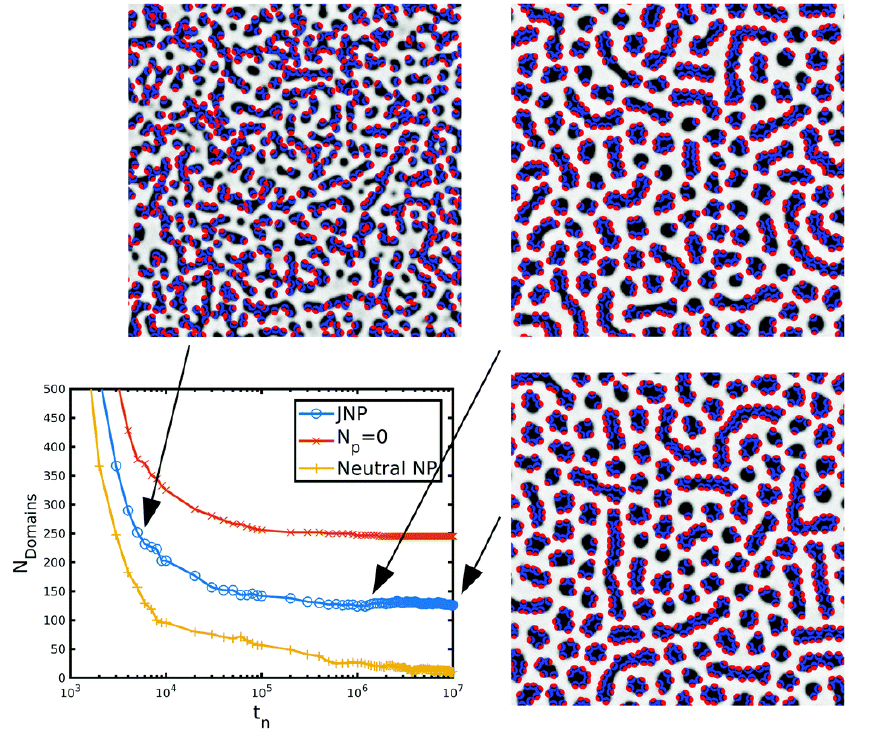
Figure 20. Time evolution of the number of BCP domains in the presence of JNPs, no particles and homogeneously coated NPs, along with several images of the simulation results. The pure BCP is cylinder-forming ( f 0 = 0.35) while the presence of the JNP favours domain merging. The curves for pure BCP ( N p = 0) and homogeneous neutral NPs are also shown for comparison. Reprinted with permission from Ref. [171] Copyright 2019 Royal Society of